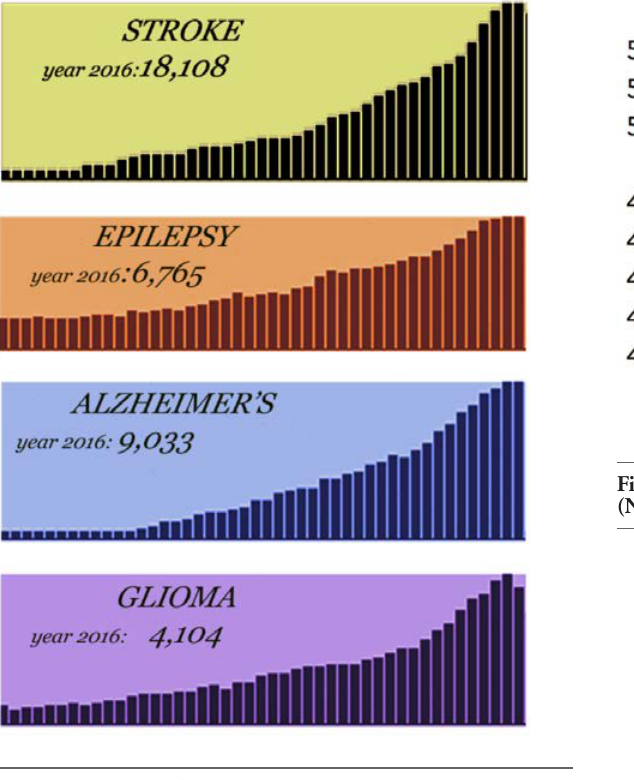
Figure 1. Bar graph for relative growth in annual publication rates for stroke, epilepsy, Alzheimer’s disease, and glioma (last year of data entry for all of the graphs is 2016).